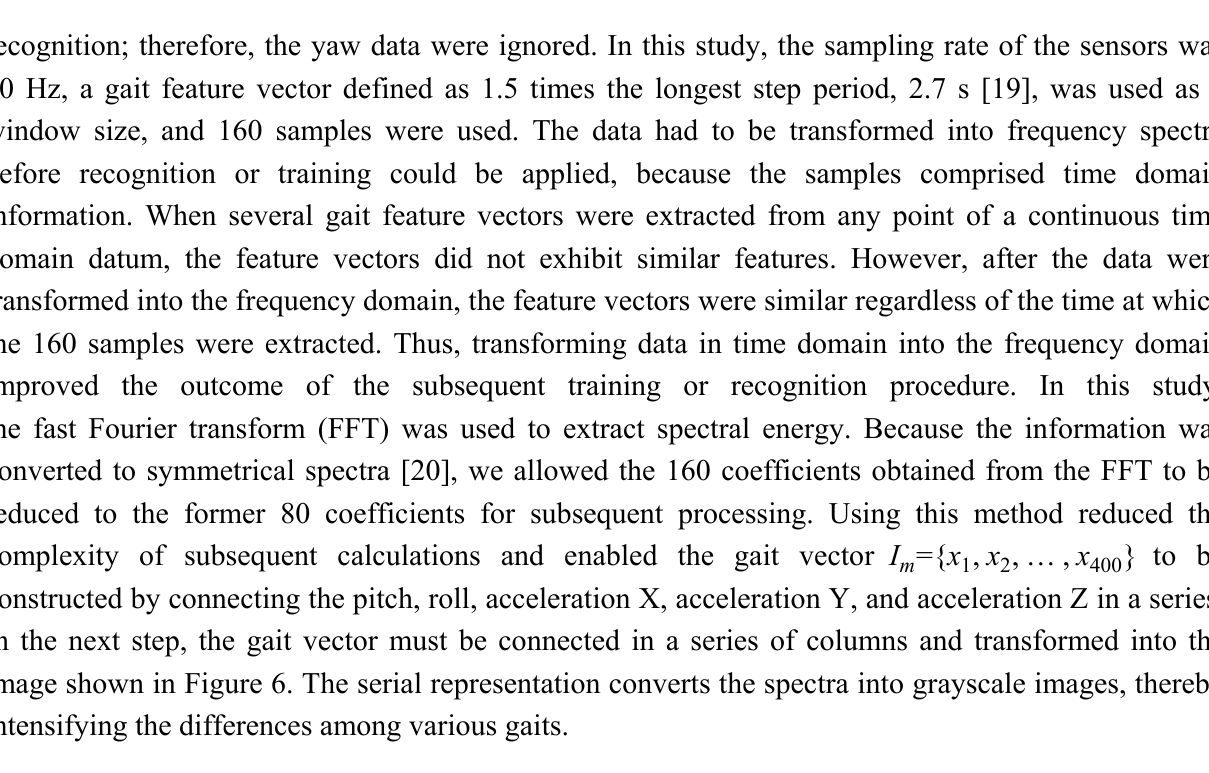
Figure 6. Representation of the gait vector transferring to an